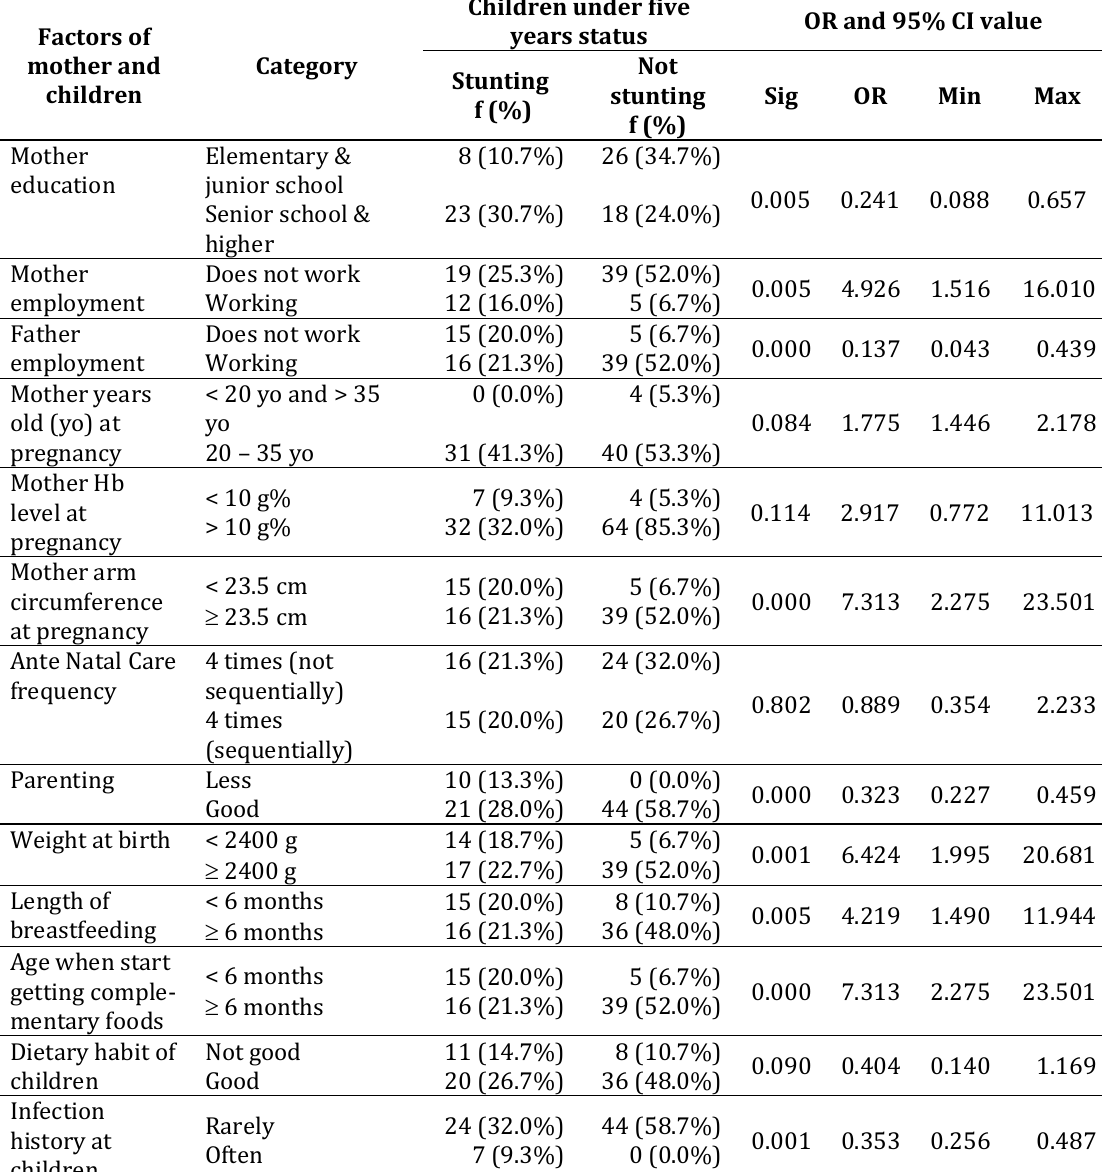
Cross-tabulation between children under five years status with factors of mother and